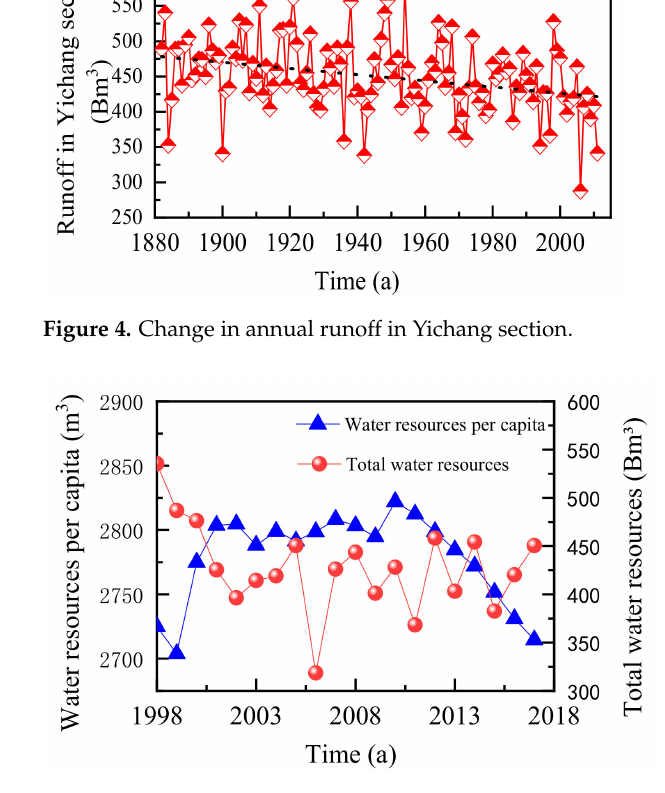
Figure 5. Change in water resource in Yichang